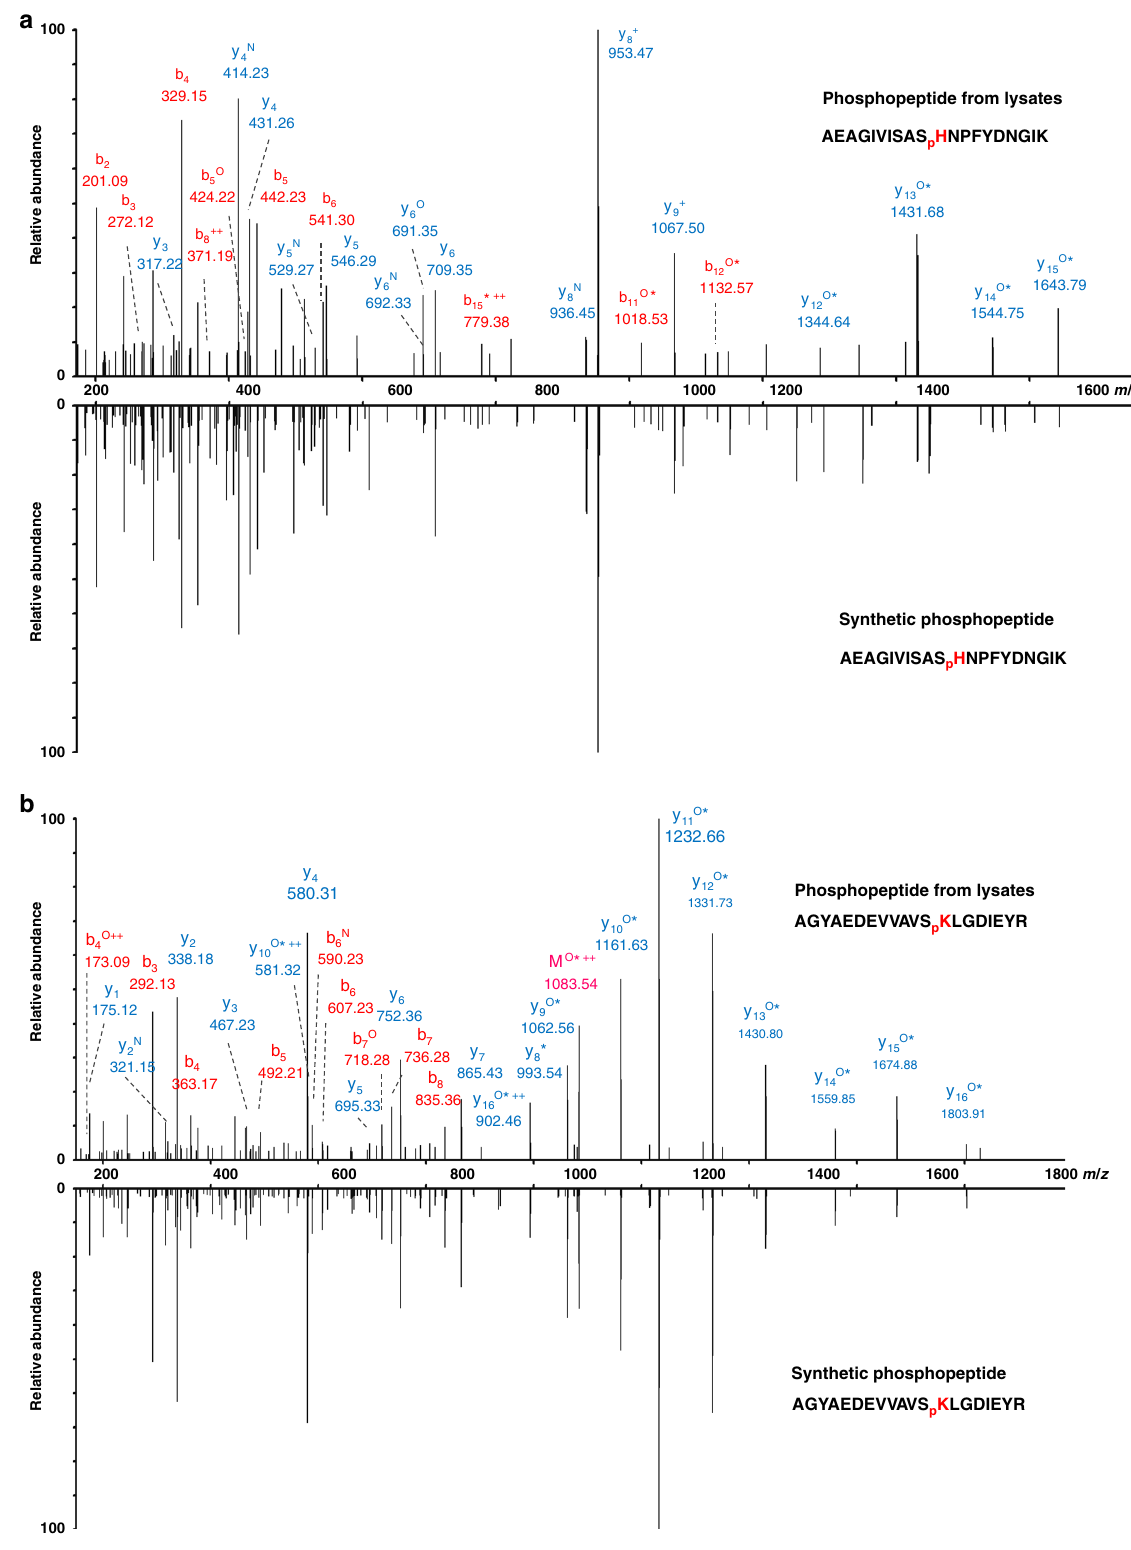
Fig. 4 MS/MS validation of Y fi D pHis and pLys peptides in E. coli . a MS/MS spectra of the endogenous E. coli Y fi D pHis peptide (AEAGIVISAS p HNPFYDNGIK) and b pLys peptide (AGYAEDEVVAVS p KLGDIEYR). The synthetic peptides are shown in the mirror image. The superscript asterisks, N, and O indicate the dephosphorylated ( − 79.97 Da), deamination ( − 17.03 Da), and dehydrated ( − 18.01 Da) ions, respectively. These graphs are made with origin